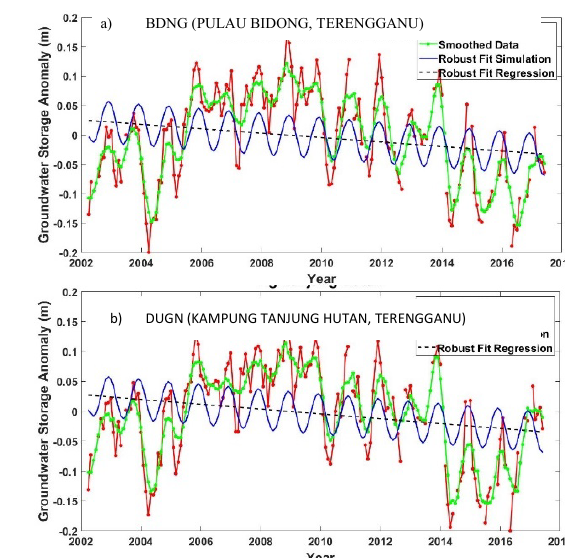
Figure 5. The rate of GWS at JMG tube well at BDNG, Pulau